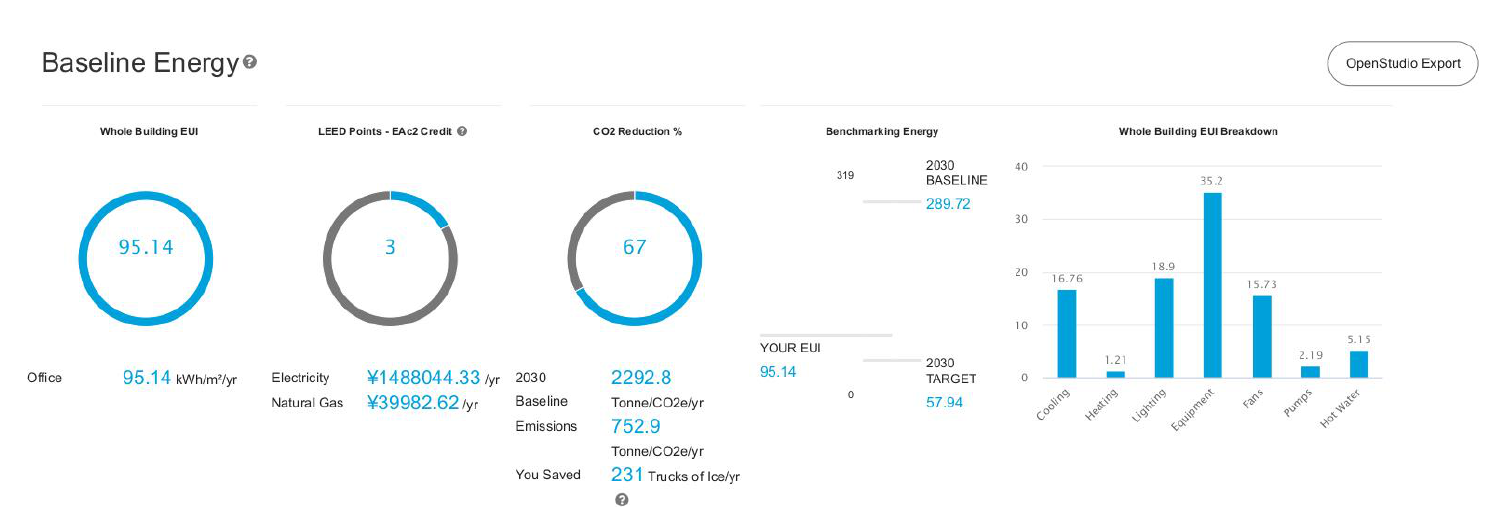
Figure A3. Zone 1-A Haikou, Hainan (post-COVID-19 84% scenario).